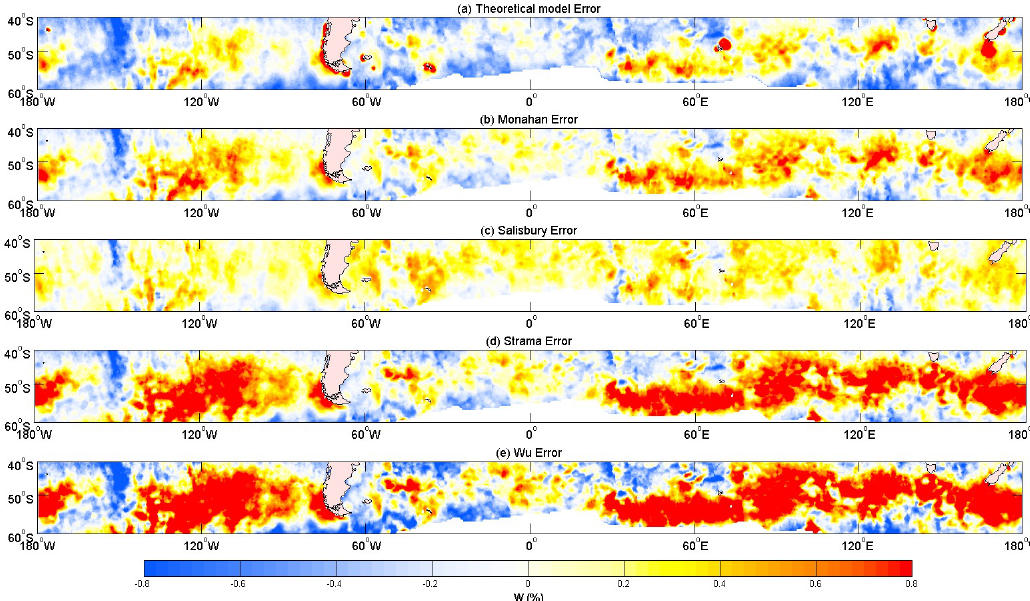
Figure 10. Comparison between errors from different whitecap models, and satellite data over 40 ◦ S–60 ◦ S and 180 ◦ E–180 ◦ W (from top to bottom): ( a ) statistical theoretical model of the whitecap coverage ( C en = 0.1777, n = − 1.713, θ = 11, F T = 0.75, ρ = 0.53), ( b ) Monahan’s empirical relationship [58], ( c ) Salisbury’s fitting formula [20], ( d ) Strama’s empirical relationship [40], and ( e ) Wu’s empirical relationship [37]. A unified scale colorbar with values from −0.8 to 0.8% is used.